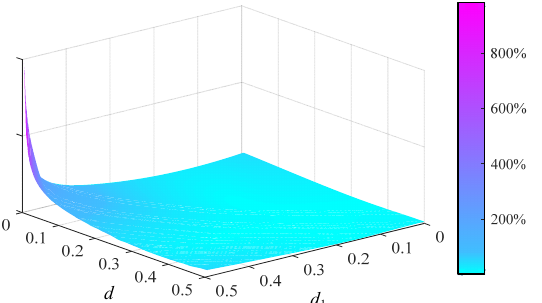
Figure 5. The relationship between phase shift ratio and THD i P with DPS modulation.